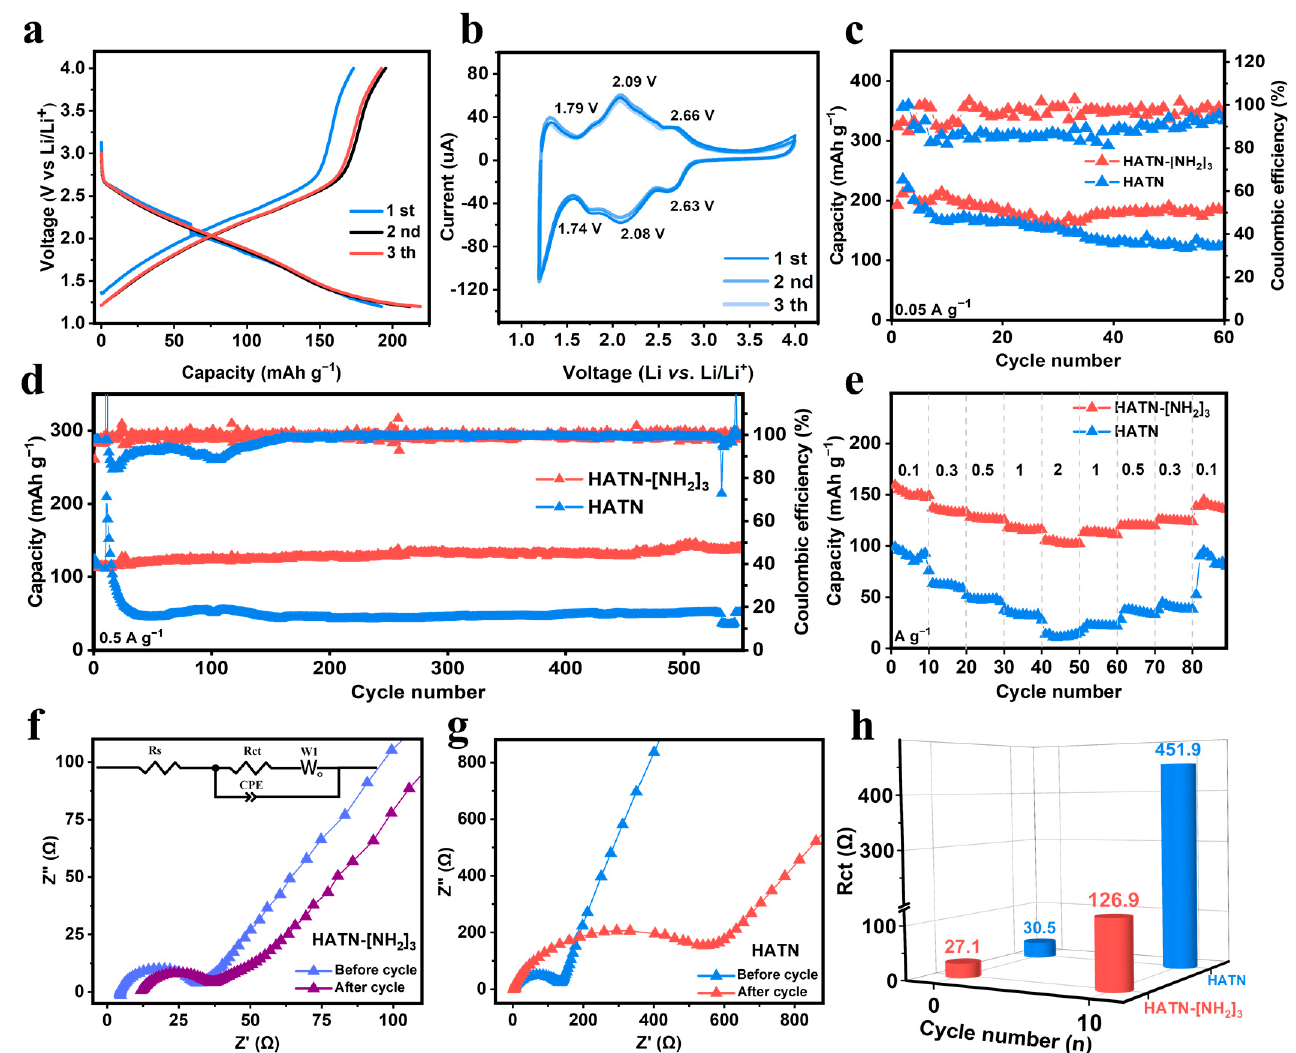
Figure 3. Electrochemical performance of HATN-[NH 2 ] 3 and HATN cathodes. ( a ) Discharge and charge curves of first three cycles for HATN-[NH 2 ] 3 at 0.05 A g − 1 . ( b ) CV curves of HATN-[NH 2 ] 3 at first three cycles at 0.2 m V s − 1 . ( c ) Cycling performance of HATN-[NH 2 ] 3 and HATN at a current density of 0.05 A g − 1 . ( d ) Long-term cycle stability of HATN-[NH 2 ] 3 at a high current density of 0.5 A g − 1 . ( e ) Rate capabilities of HATN-[NH 2 ] 3 and HATN electrodes. ( f , g ) Nyquist plots of HATN-[NH 2 ] 3 and HATN electrodes before and after 10 cycles. The inset in ( f ) is the corresponding equivalent circuit diagram. Rs, Rct, W1, and CPE represent the surface contact resistance, the charge-transfer resistance, the Warburg impedance, and the constant phase elements, respectively. ( h ) Charge-transfer resistance (Rct) of HATN-[NH 2 ] 3 and HATN electrodes before and after 10